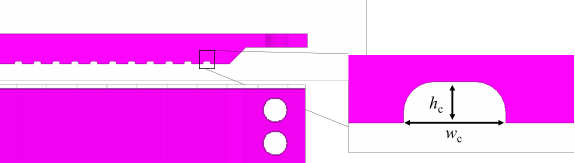
Figure 15. Geometrical sketch of the micromachined aluminum encapsulations to implement the